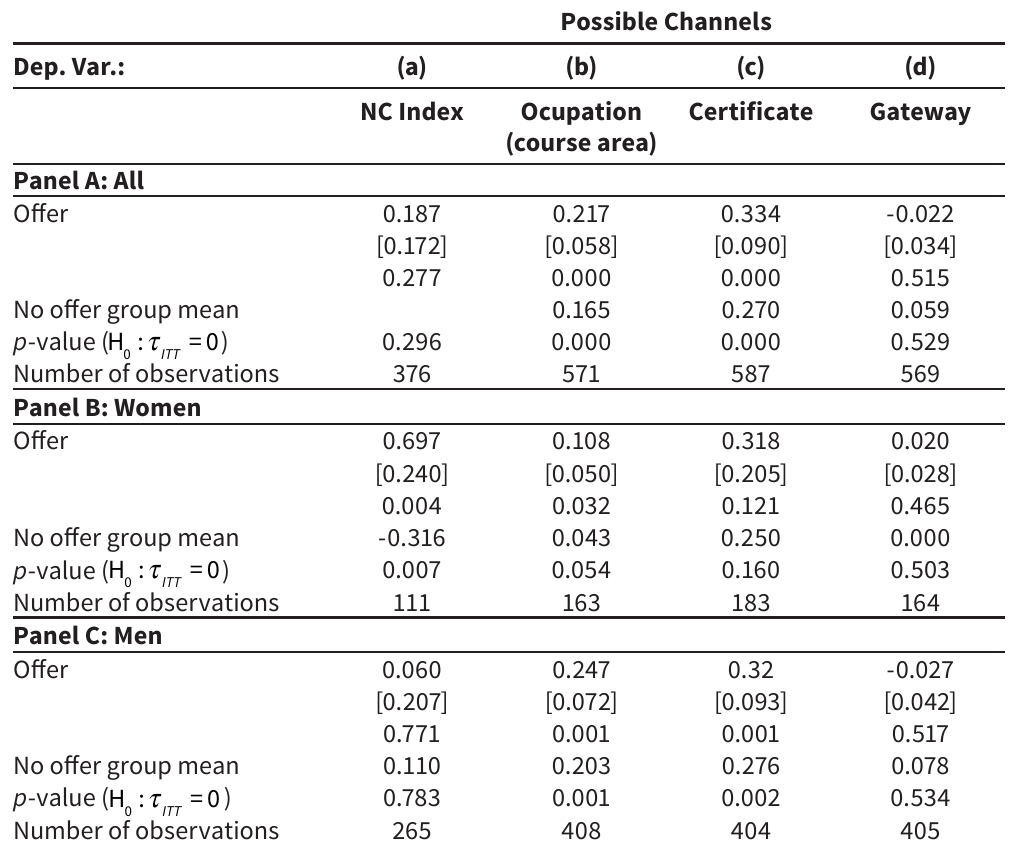
LATE Estimates on Possible Channels Outcomes